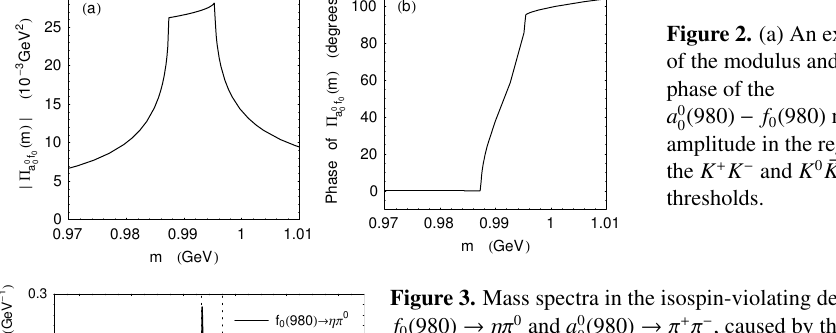
(980) → ηπ 0 ) = 0 (cid:12) (cid:12) (cid:12) (cid:12) (cid:12)